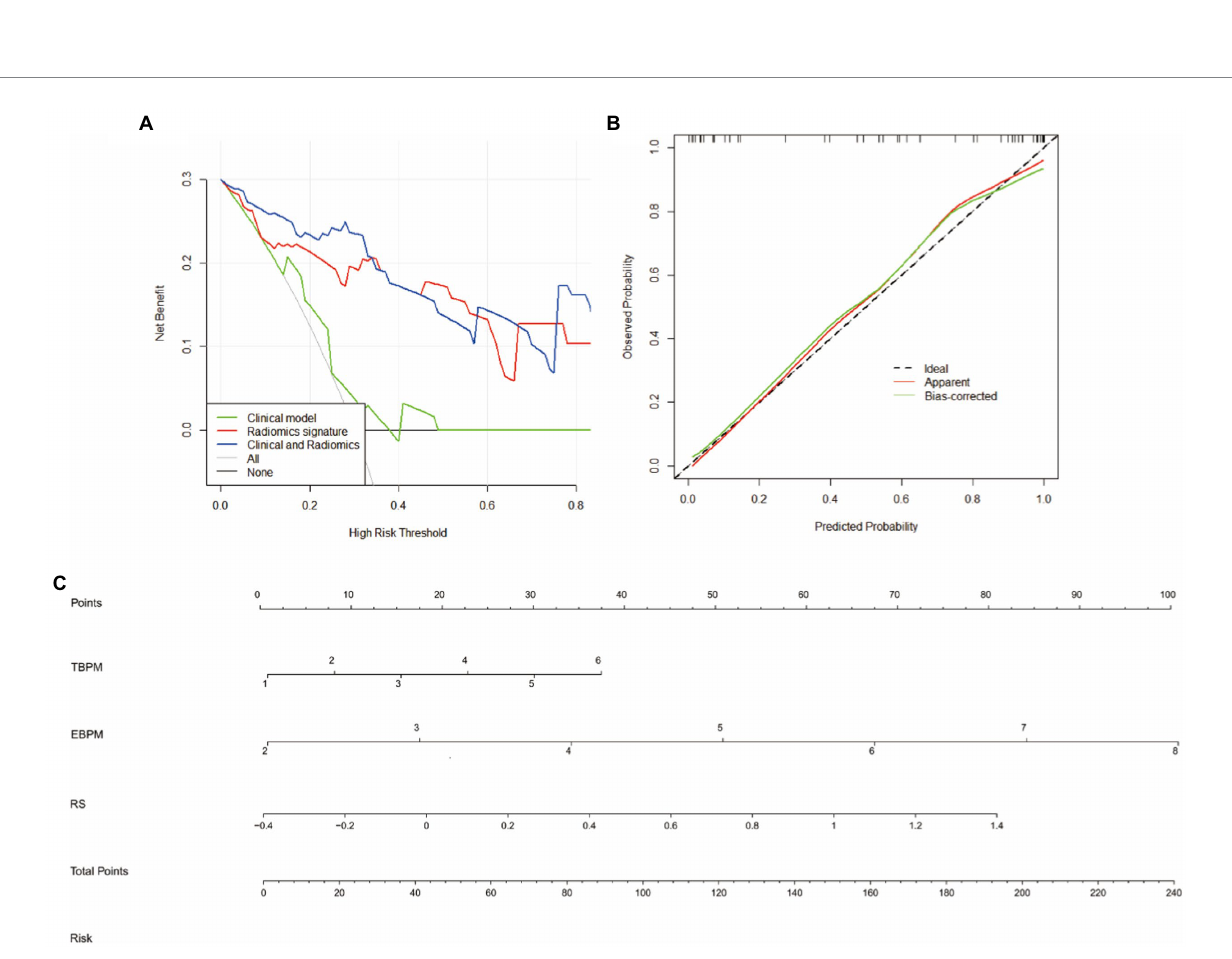
FIGURE 6 Nomogras, calibration curves, and decision curves for building a model based on radiomic and clinical features. (A) Decision curves. Red, green, and blue lines represent the clinical, radiomic, and integrated models, respectively. The y -axis indicates the net benefit, while the x -axis indicates the threshold probability. The integrated model had a higher overall net gain in distingguishing WD from WD with cognitive impairment when compared with the clinical and radiomic models. (B) Calibration curves indicating the goodness of fit of the nomograms. The 45 ° straight line indicates a perfect match between the actual ( y -axis) and predicted ( x -axis) probabilities of the column plots. Closer distances between the two curves indicate higher accuracy. (C) Nomograms, time-based prospective memory (TBPM), event-based prospective memory (EBPM), and Radscores were used to build nomograms for clinical